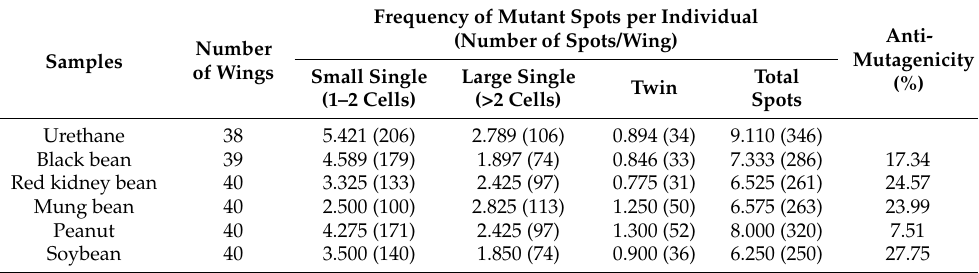
Table 3. Frequency of mutant spots observed in trans-heterozygous, high bioactivation (HB) flies treated with urethane alone or bean milk together with urethane in the co-administration study.